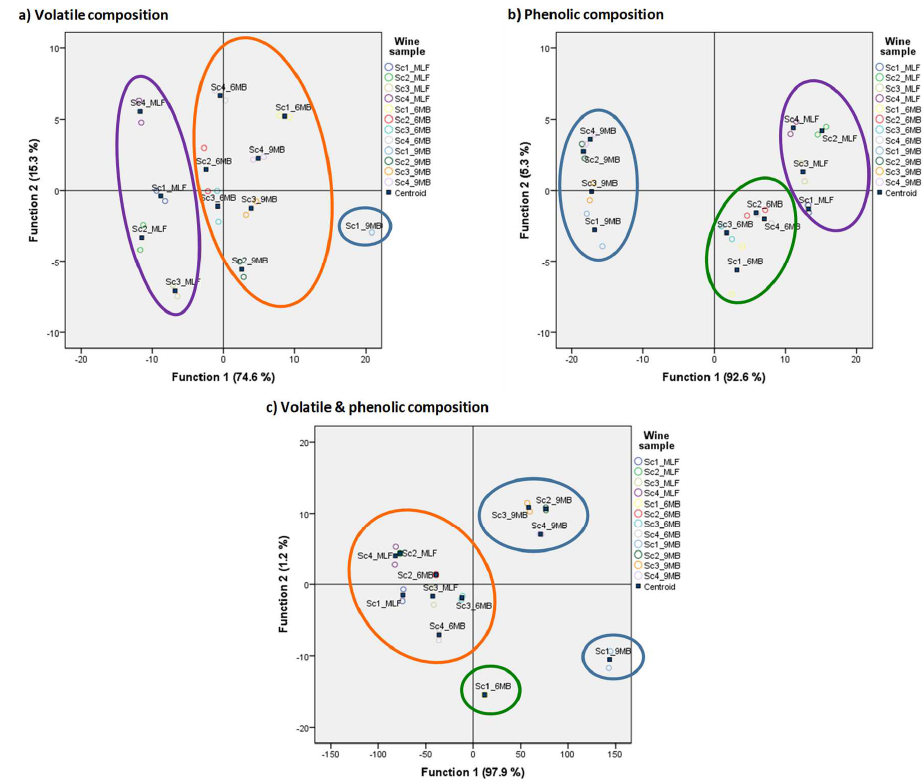
Figure 5. Discriminant analysis carried out with ( a ) volatile compounds concentration (mg/L), ( b ) phenolic compounds concentration (mg/L), and ( c ) volatile and phenolic compounds concentration (mg/L) of the wines elaborated with the four yeasts (Sc1, Sc2, Sc3, and Sc4) at the three winemaking moments (end of MLF and after 6 and 9 months of aging in bottles, 6 MB and 9 MB, respectively). The percentages of aromatic and phenolic compounds variance attributable to yeast strain, aging time and their interaction (factorial analysis) are presented in Table 2. Table 2. Percentage of wine aromatic and phenolic compounds variance attributable to yeast strain (YS), aging time (AT) and YS × AT interaction. Yeast Strain (%) YS × AT (%)